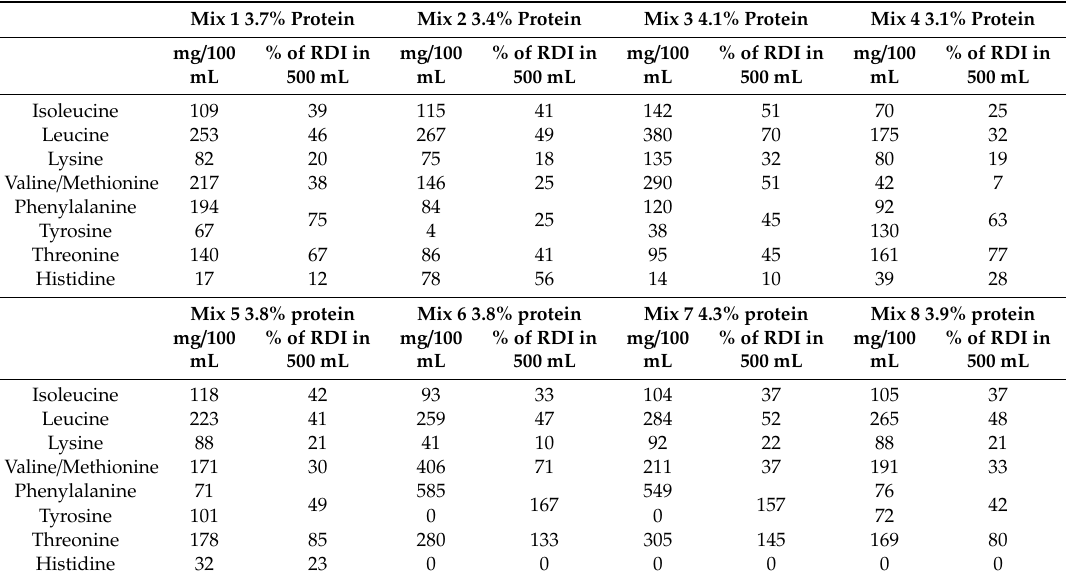
Table 4. The essential amino acids measured in the mixed